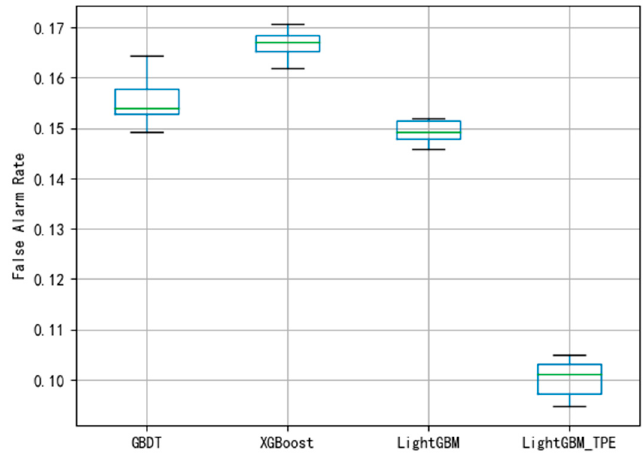
Figure 7. Missing detection rates of four algorithms for fault detection of wind turbines gearboxes on dataset 1.